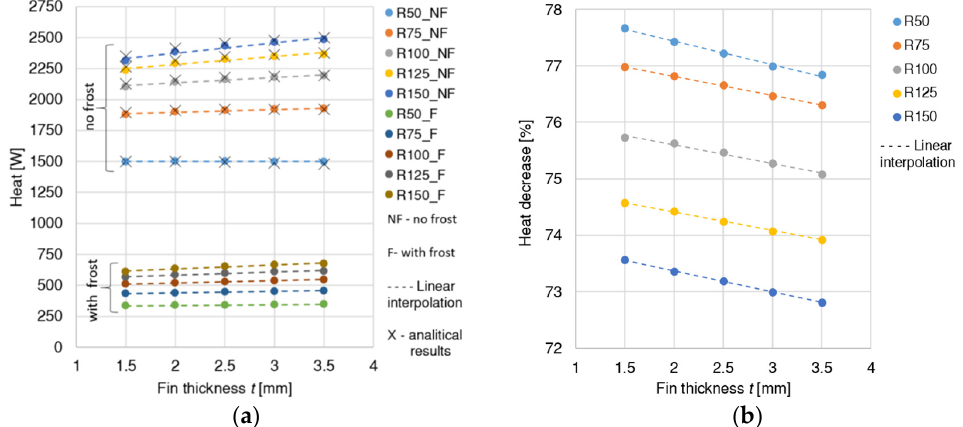
Figure 19. ( a ) Heat transferred through the 1 m length of the finned tube with 20 fins, ( b ) Heat decrease due to frosting.